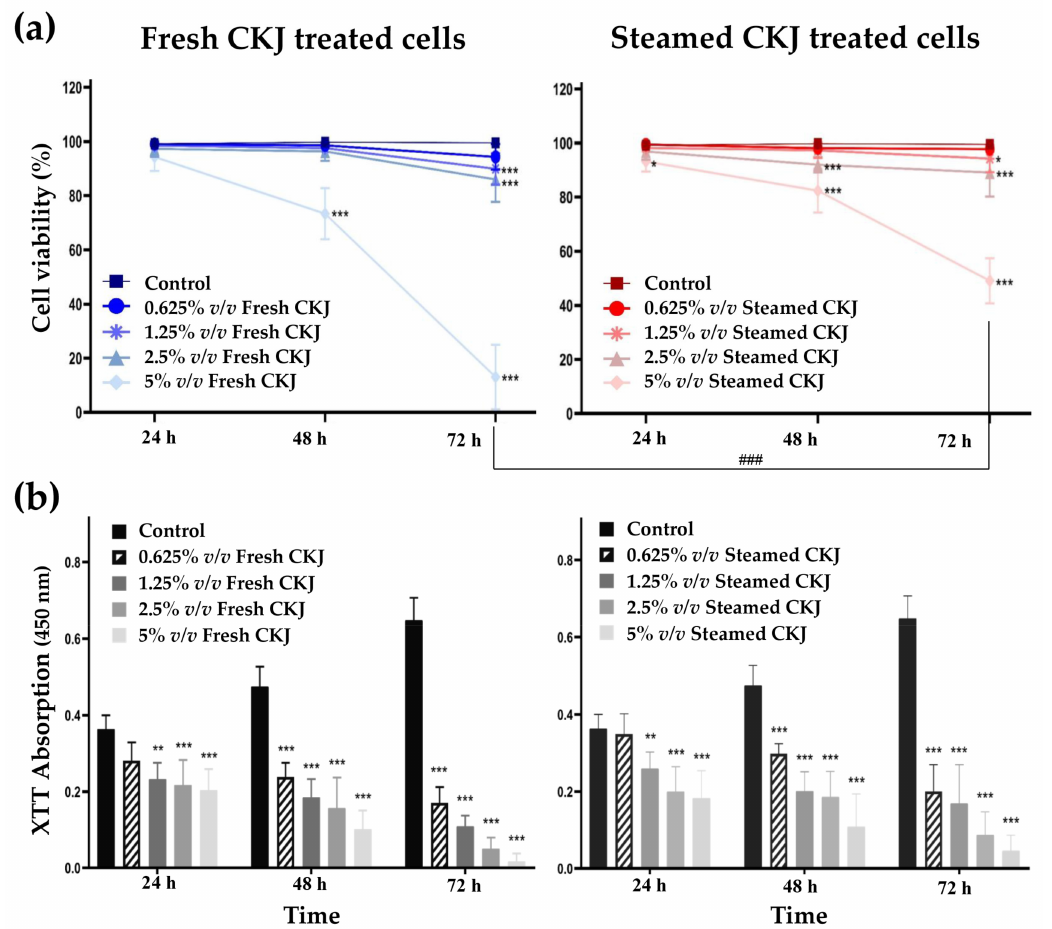
Figure 1. Effects of CKJ on U937 cell survival ( a ) and cell growth ( b ). Cells were exposed to different concentrations of fresh and steamed CKJ for 24, 48, and 72 h. The significance level of the tested sets was compared with a control (normal saline) set (* p = 0.05, ** p = 0.01 and *** p < 0.001) and fresh CKJ-treated cells were compared with steamed CKJ-treated cells (### p < 0.001). Data were representative of three independent